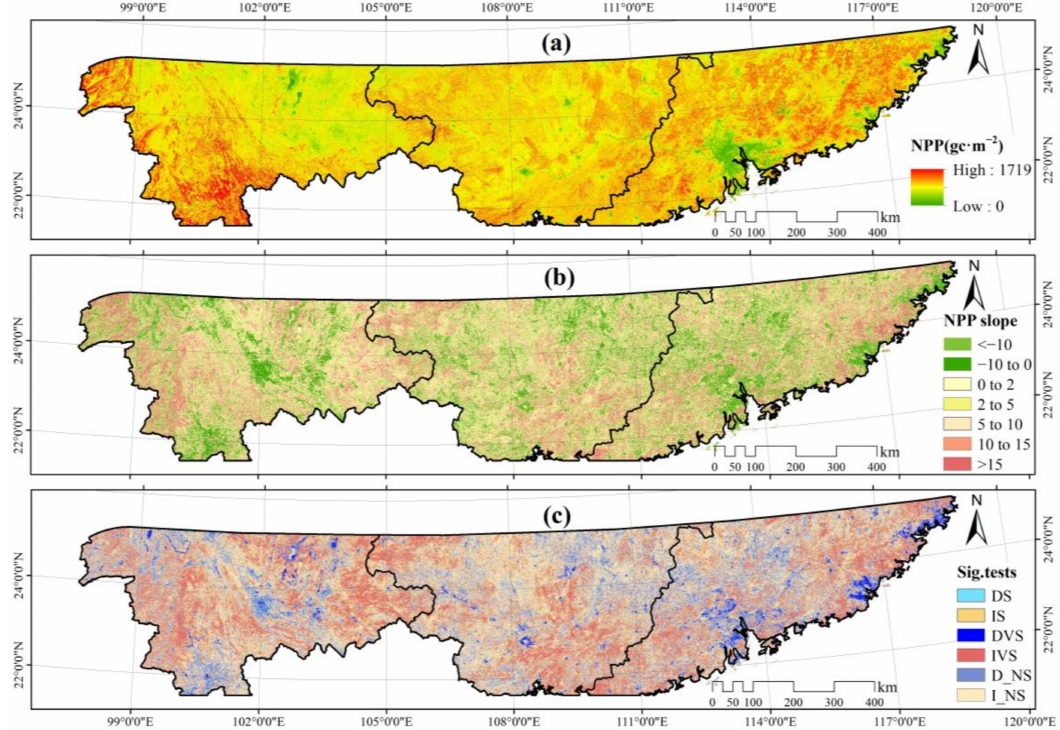
Figure 3. ( a ) Spatial patterns of mean NPP, ( b ) NPP change trends during the period 2000–2020, and ( c ) slope significance tests of NPP trends in the TCT. DS and DVS denote a significant (0.01< p ≤ 0.05) and very significant ( p ≤ 0.01) decrease, respectively; IS and IVS denote a significant (0.01< p ≤ 0.05) and very significant ( p ≤ 0.01) increase, respectively; and D_NS and I_NS denote a non-significant ( p > 0.05) decrease or